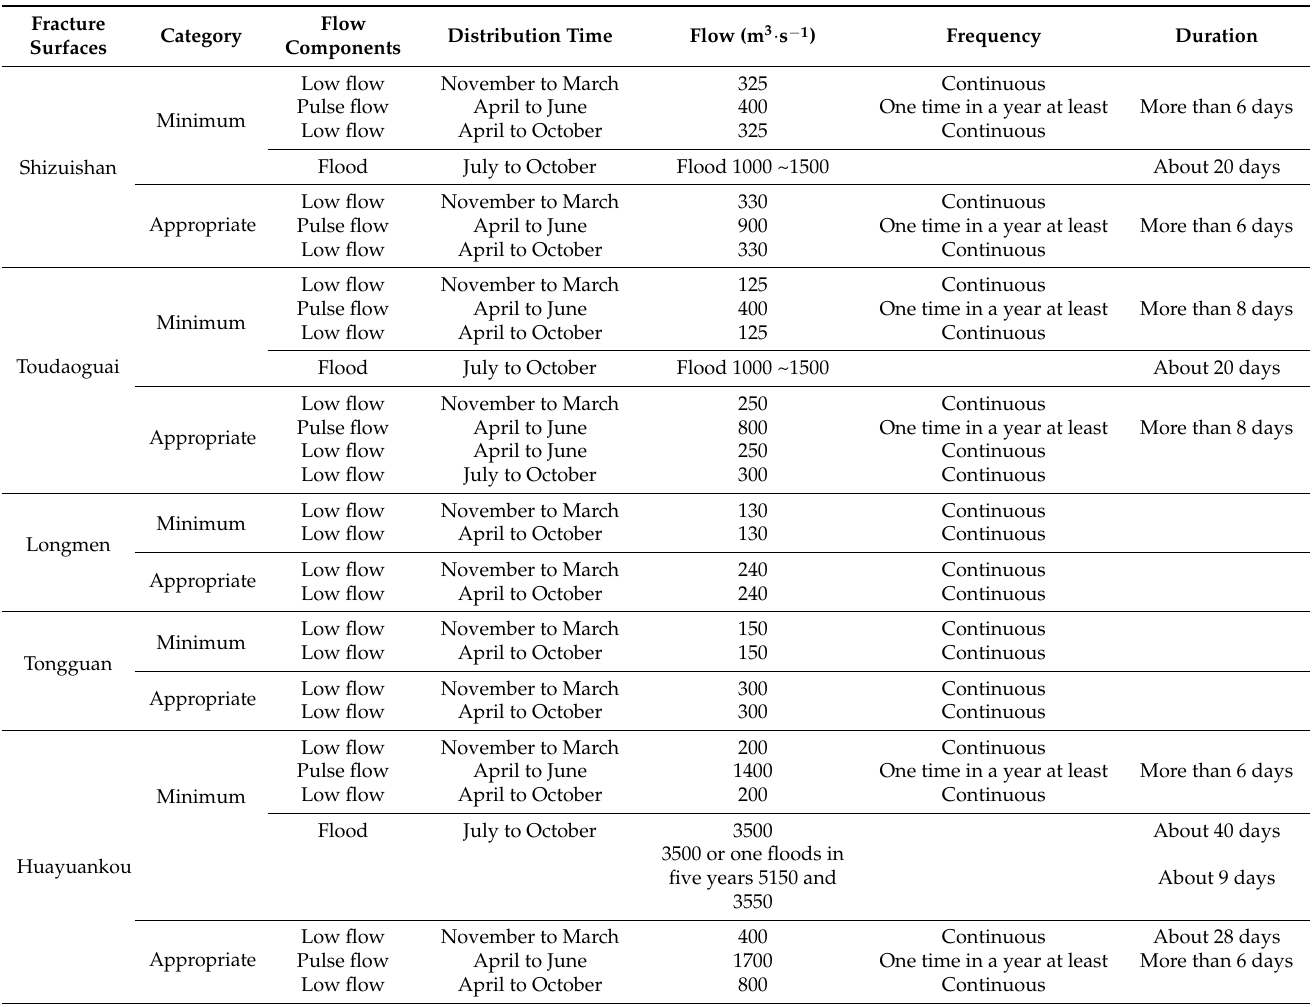
Table 4. Ecological water demand coupled results in the maintenance of the eco-hydrological connection among different sections (Shizuishan, Toudaoguai, etc.) on the Yellow